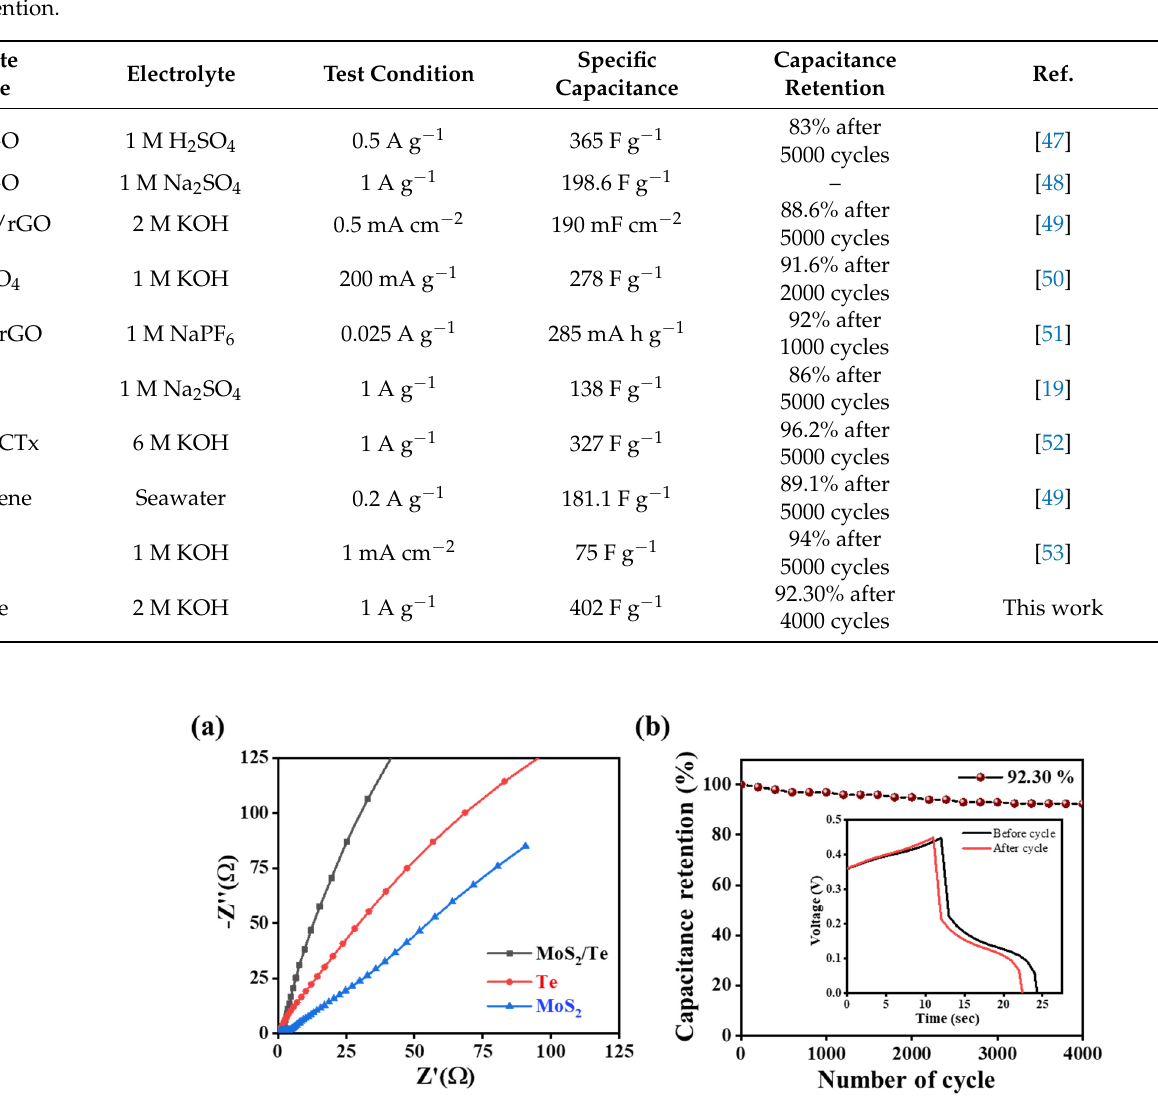
Figure 7. Electrochemical impedance spectroscopy studies of samples: ( a ) Nyquist plots of the different electrode materials recorded at (0.01 Hz to 100 kHz) and ( b ) cycling stability up to 4000 cycles.